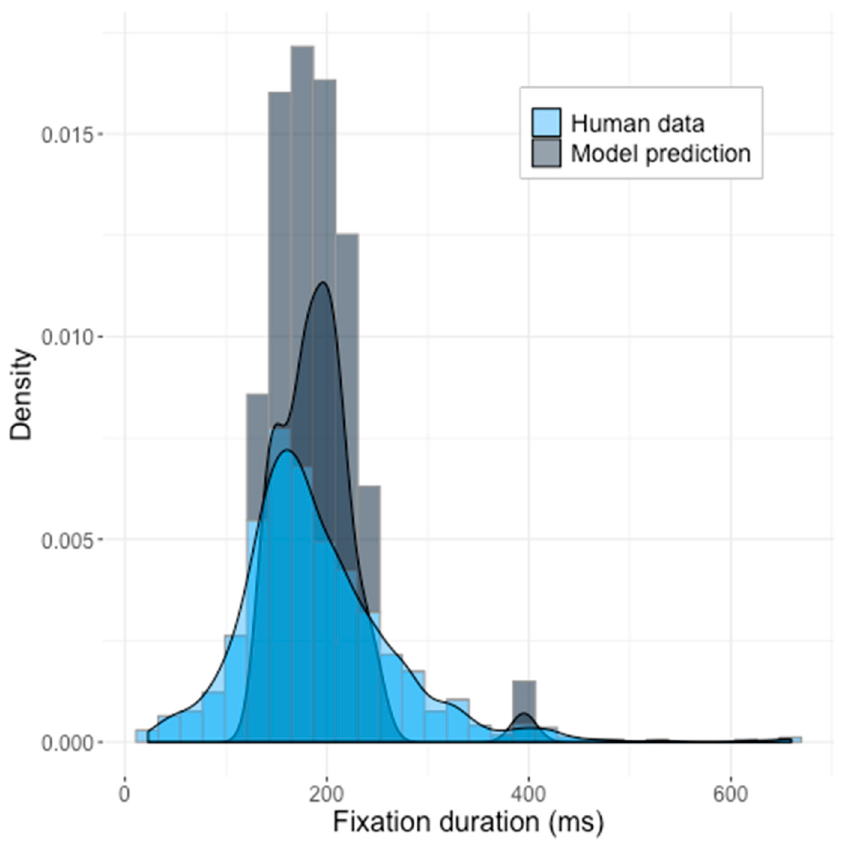
Figure 5. The predictions of the Saliency Model with the optimized set of LIF parameters from Experiment 2 pictured against the human data. The model generated one initial saccade per image (for 44 pictures).